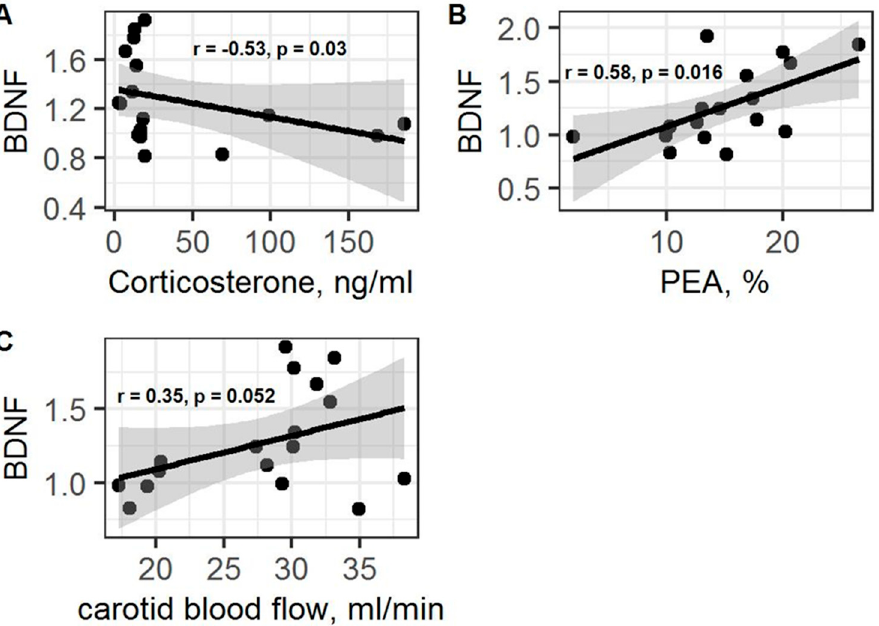
Figure 11. ( A ) Spearman correlation between BDNF and corticosterone levels in PSS rats. ( B ) Spearman correlation between BDNF and PEA values in PSS rats. ( C ) Spearman correlation between BDNF and carotid blood flow values in PSS rats. Gray area around the line represents the 95% confidence interval.